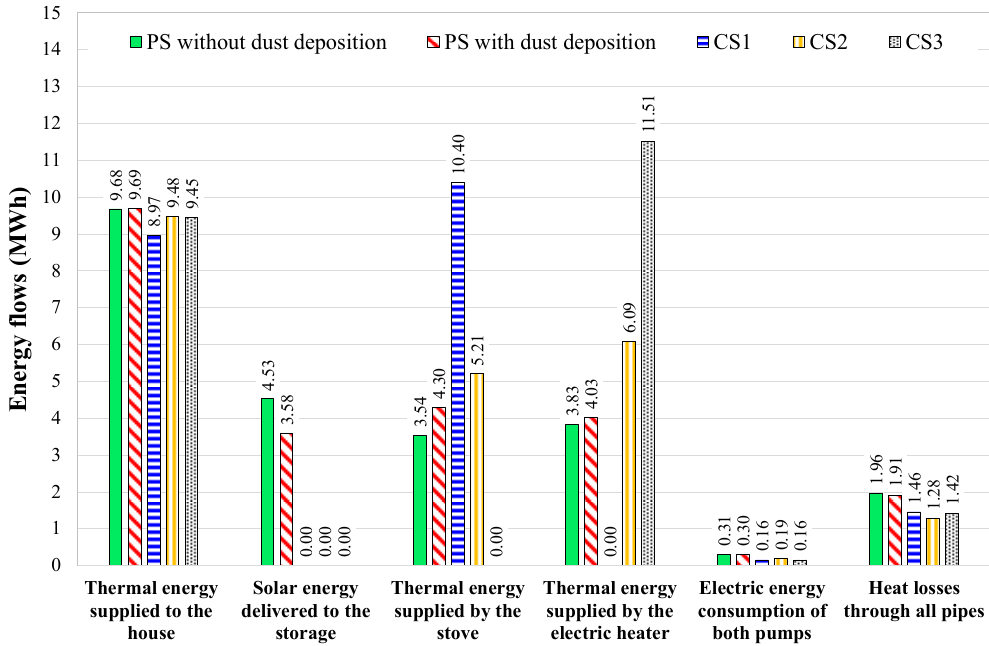
Figure 13. The energy flows associated with the operation of the proposed system (with and without dust deposition) as well as the conventional systems CS1, CS2 and CS3.